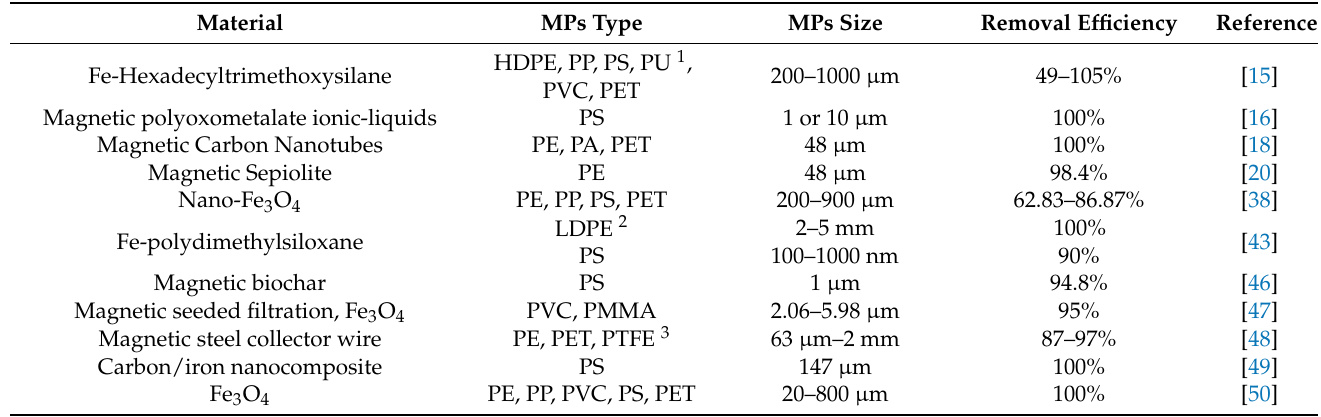
Figure 4. Results from recovery experiments of PE, Weathered PE 1000h (<100 µ m) and TWP, Weathered TWP 1000h (300–600 µ m). Error bars show standard deviation. Table 2. Reported literature on the magnetic separation of the MPs.